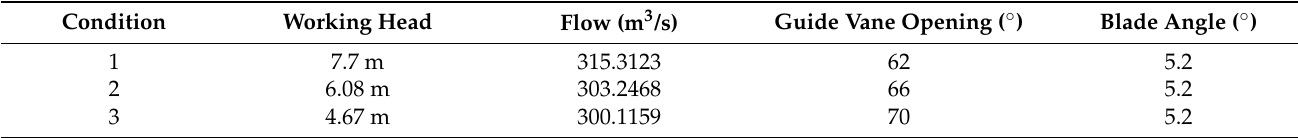
Figure 5. Water head diagram of horizontal tubular turbine. Table 1. Specific parameters at different working conditions.